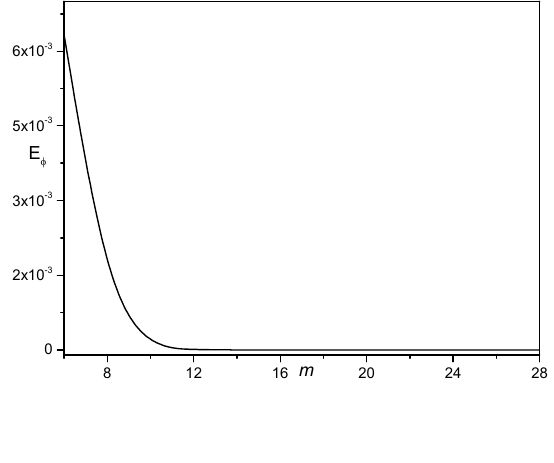
Fig. 7 The average residual error of φ ( η